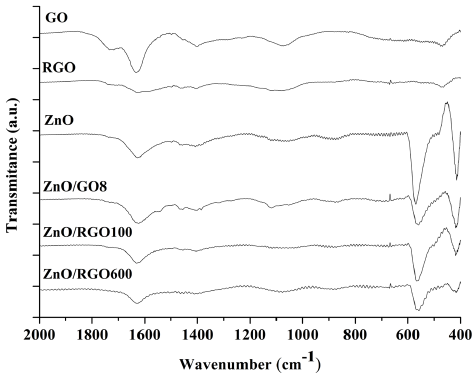
Figure 2. FTIR spectra of synthesized GO, RGO, ZnO, and composites.